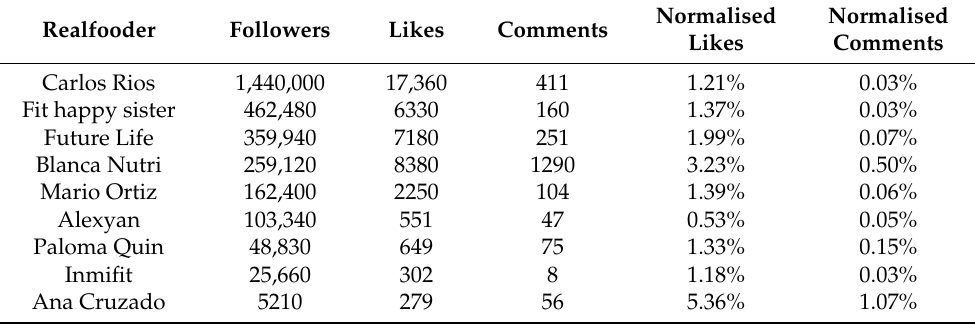
Table 1. Normalized indicators of the interaction of the Realfooders. Realfooder Followers Likes